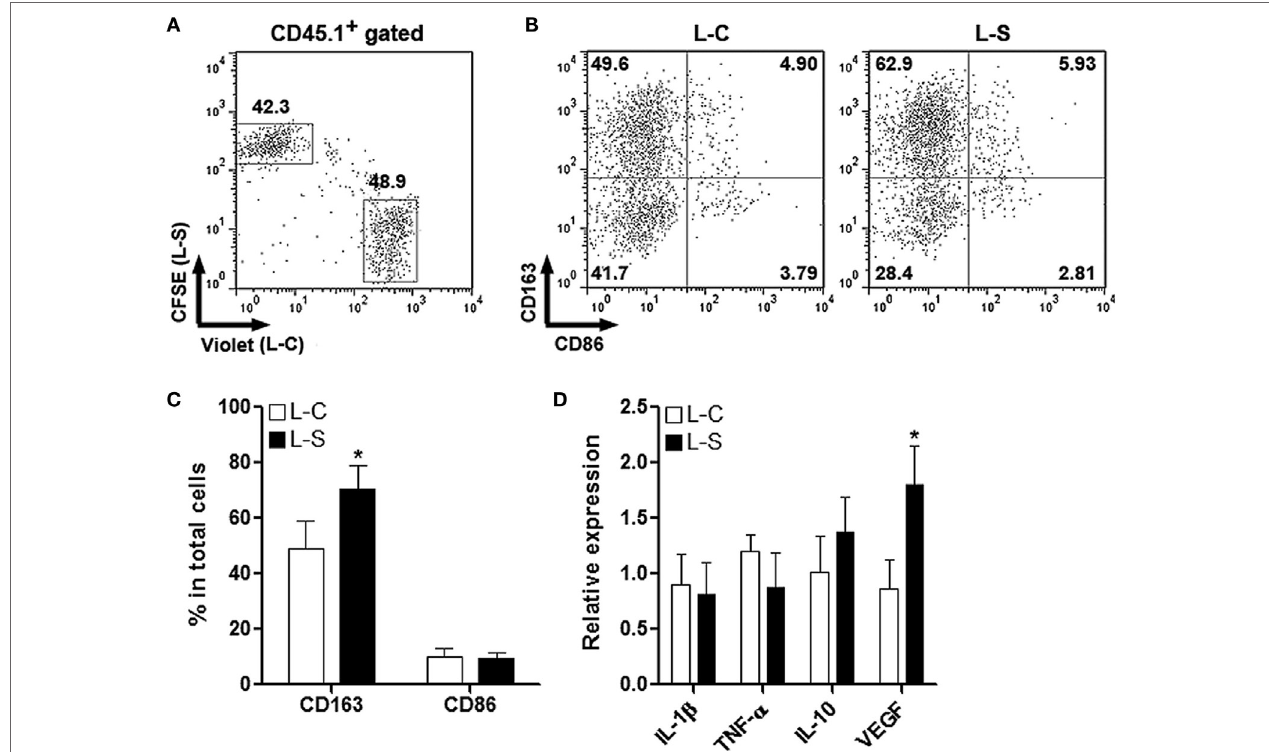
FigUre 4 | Ectopic Sestrin2 expression in M2 macrophages has limited effects in vivo . (a) Detection of adoptively transferred M2 macrophages in infarcted myocardium at day 3 after myocardial infarction. Note that M2 macrophages were derived from C57BL/6.SJL mice, transduced with lentivirus (L-C or L-S, respectively), and labeled with CellTrace Violet or carboxyfluorescein succinimidyl ester (CFSE) before adoptive transfer. Numbers in the plots are proportions of gated cells populations. (B,c) Expression of CD163 and CD86 on transferred M2 macrophages. (B) Representative dot plots. (c) Statistics. L-C: M2 macrophages transduced with control lentivirus. L-S: M2 macrophages transduced with SESN2 lentiviral activation particles. (D) mRNA abundance of indicated cytokines in transferred M2 macrophages. N = 3 per group. * p < 0.05 in comparison with